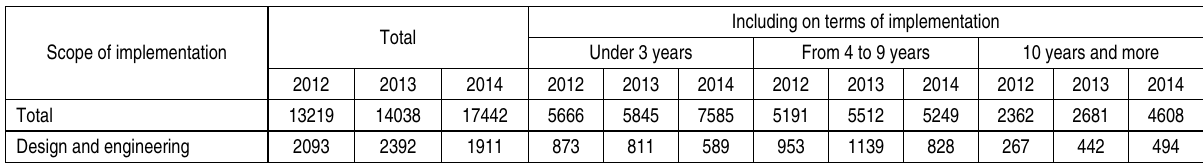
Table 1. The dynamics of the use of advanced technologies in the context of scope and the duration of implementation